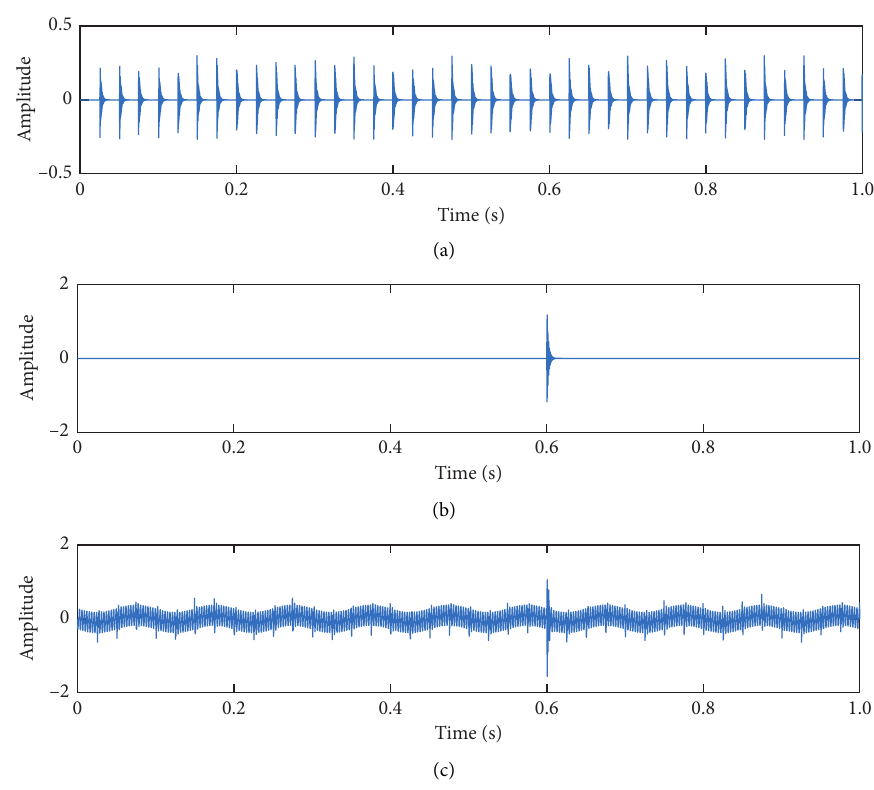
Figure 3: Simulated signals of case 1: (a) fault impulses, (b) random impulse, and (c) pure signal.